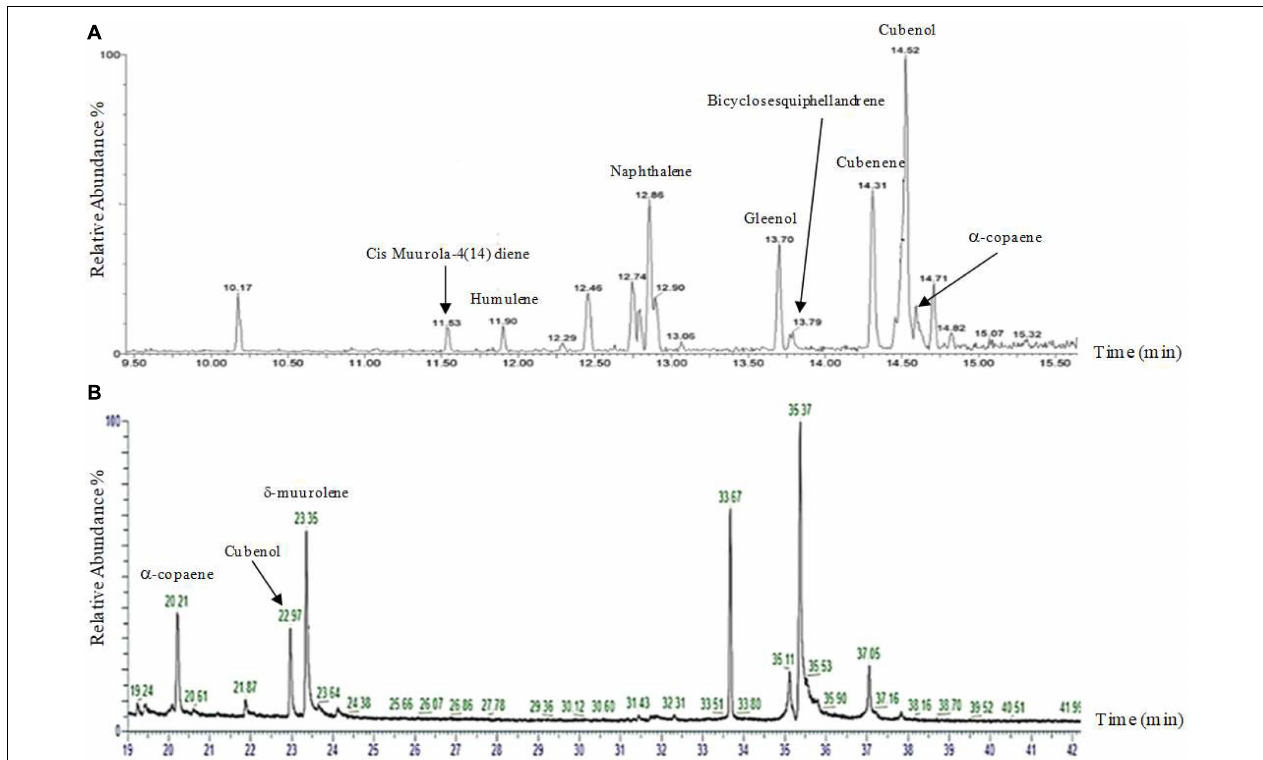
FIGURE 8 | Gas chromatography–mass spectrometry (GC-MS) comparison of the sesquiterpene synthase Cop4. (A) GC-MS analysis of the NSAR1-Cop4 transformant. Eight compounds [muurola-4(14)diene, humulene, naphthalene, gleenol, cubenene, bicylosesquiphellandrene, Cubenol, and alpha-copaene] were characterized using HP-5 MS quartz capillary column (30 m × 0.25 mm, 0.25- µ m film thickness). (B) GC-MS analysis of the NSAR1-Cop4 transformant. Three compounds (alpha-copaene, Cubenol, and sigma-muurolene) were characterized using HP-1 (50 m × 0.32 mm, 0.17- µ m phase